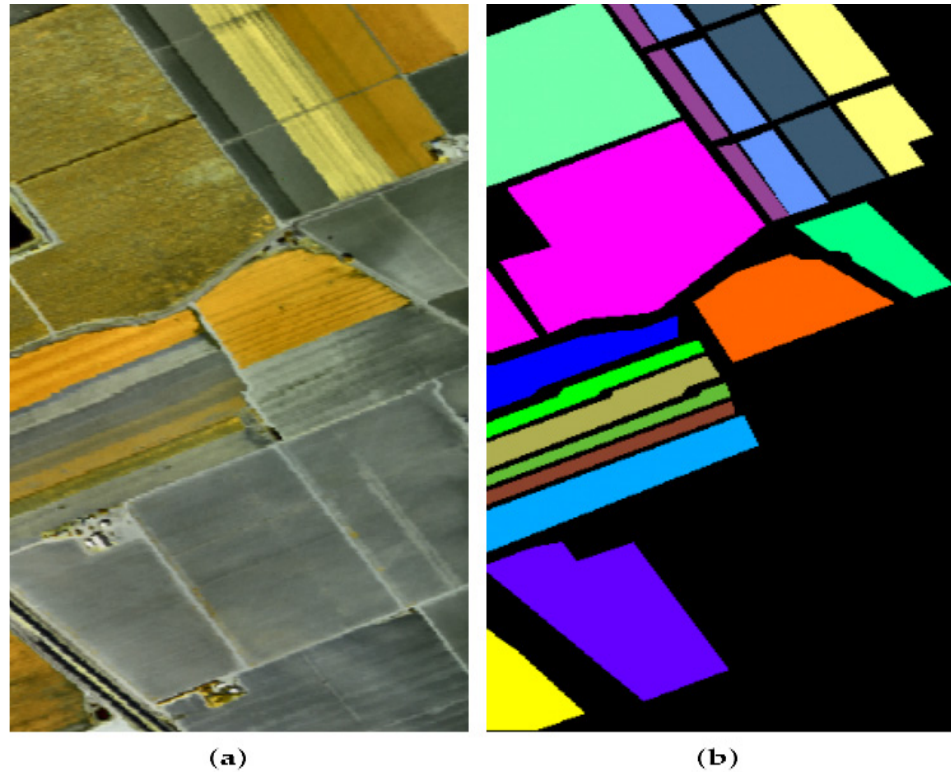
Figure 12. Detection of Areas in Salinas Dataset: ( a ) Segmented Image; ( b ) Detection.